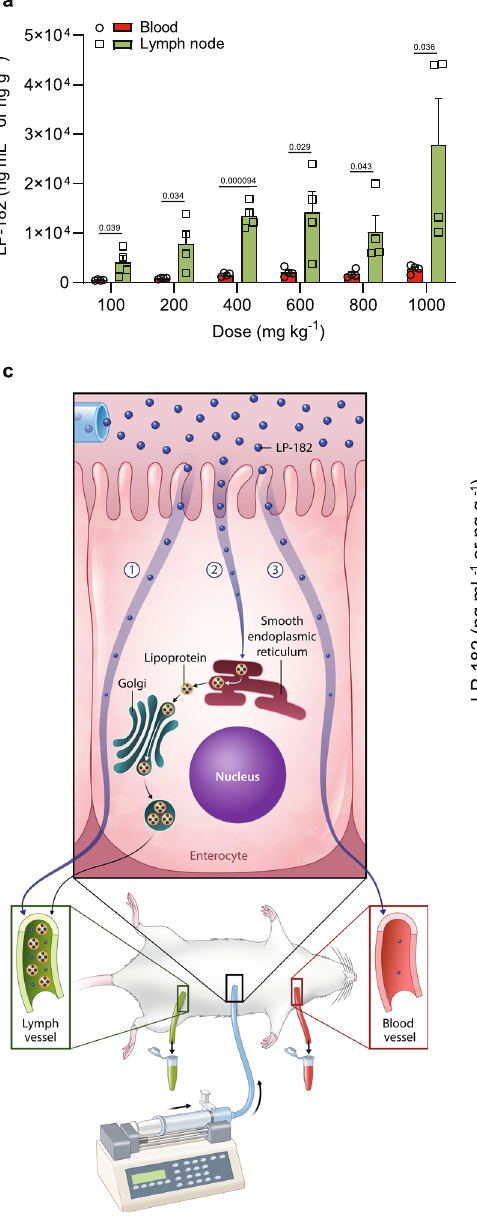
Fig. 3 | Absorptive lymphatic partitioning of LP-182 involves association with lipoproteins. a Concentration of LP-182 in blood and mesenteric lymph nodes from mice 30min following oral administration at the indicated doses. Data represent the mean±s.e.m., n =4 animals per dose. Statistical signi fi cance determined using multiple unpaired t-test corrected with Holm- Š idák multiple comparisons test (100mgkg − 1 , p =0.039; 200mgkg − 1 , p =0.034; 400mgkg − 1 , p =0.000094; 600mgkg − 1 , p =0.029; 800mgkg − 1 , p =0.043; 1000mgkg − 1 , p =0.036). b Concentration of LP-527, PD0316684, and LP-182 in blood and mesenteric lymph nodes from mice 4h following oral administration